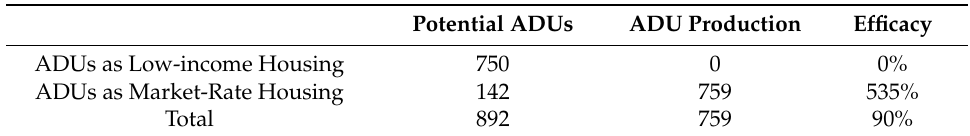
Table 6. The sample’s efficacy of counting potential ADUs to ADU production. The sample’s potential ADUs achieved an efficacy of 90% for ADUs overall in contrast with a 0% efficacy for ADUs towards low-income housing. Notes: ADU = Accessory Dwelling Unit.